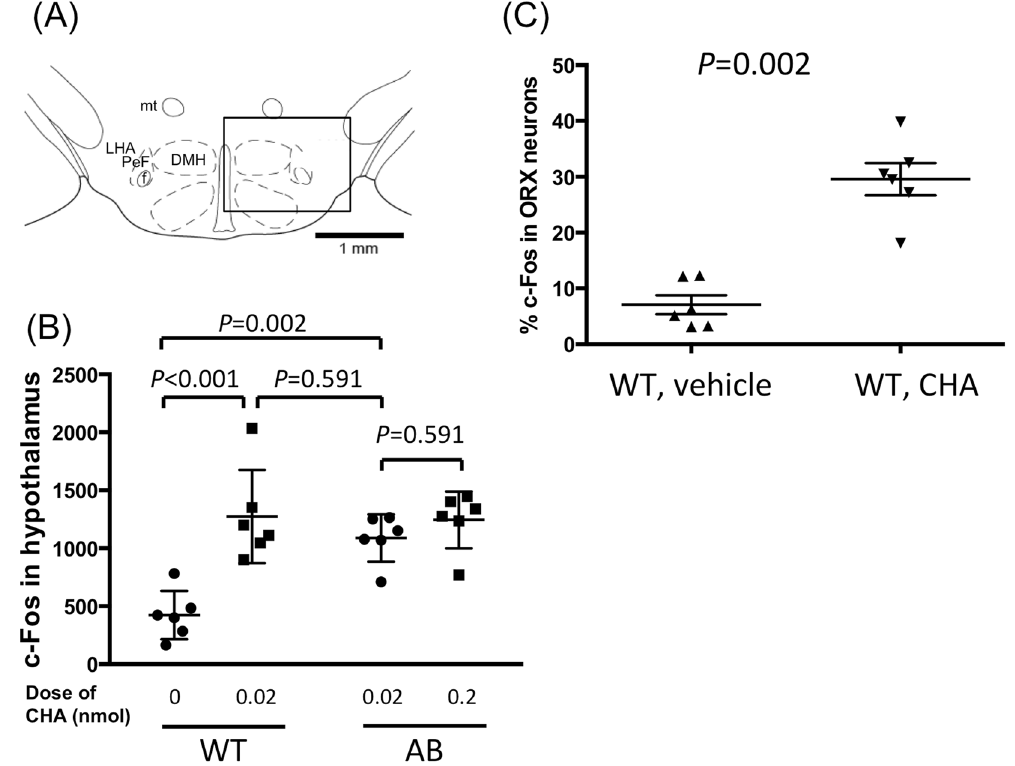
Figure 6. Activation of orexin neurons by CHA. ( A ) Square field denotes counting area for immunoreactivity. ( B ) The number of c-Fos positive cells among 4 groups of the mice: WT mice treated with vehicle, WT mice treated with 0.02 nmol of CHA, ORX-AB mice treated with low dose (0.02 nmol) of CHA, and ORX-AB mice treated with high dose (0.2 nmol) of CHA. 2-way ANOVA indicated there was statistical difference between doses (F 1,20 = 7.89, p < 0.0108) and between genotypes (F 1,20 = 19.86, p = 0.0002). P values were calculated using the Holm-Sidak multiple comparison test. ( C ) Percentage of the number of double positive cells among